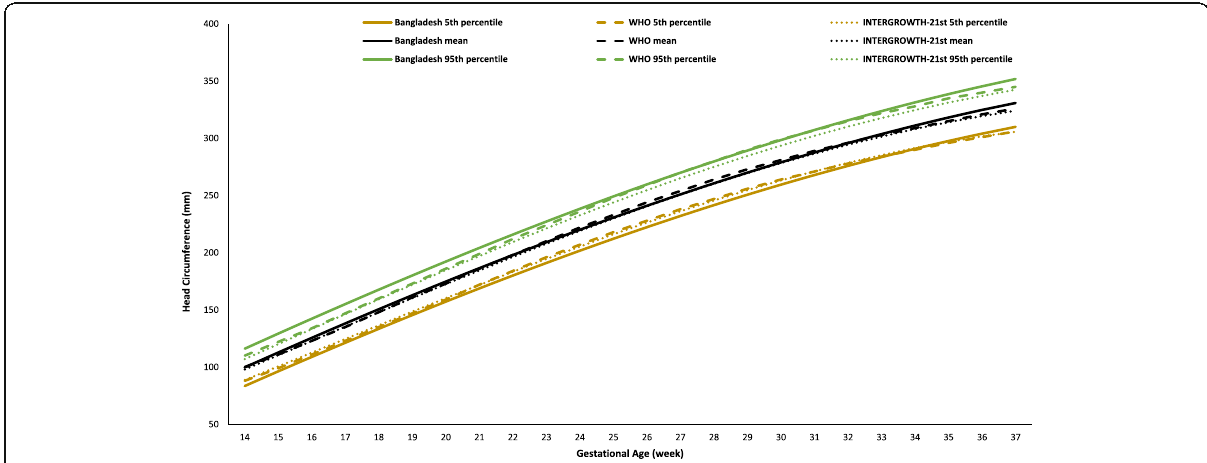
Fig. 3 Comparison of head circumference (HC) with WHO [11] and INTERGROWTH-21st [16]